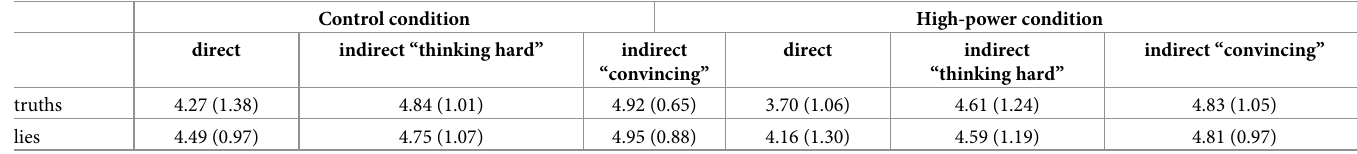
Table 2. Mean scores (with accompanying SDs) for the indirect and direct conditions as a function of power and veracity (Study 2). Control